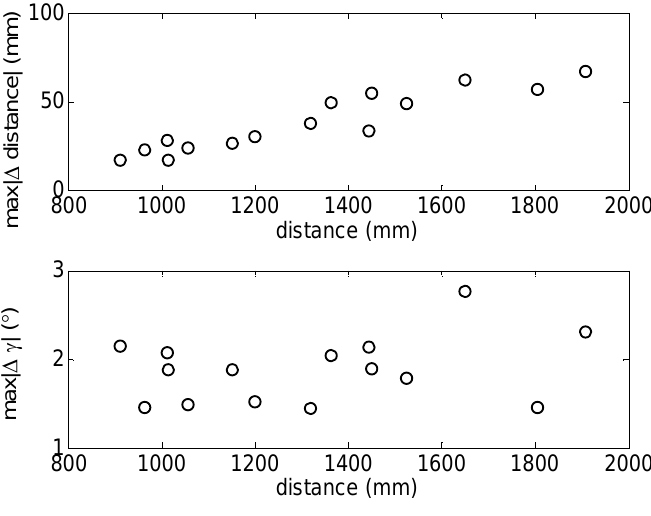
Figure 14. Maximum incremental values of the distance (top) and relative angular orientation (bottom) of the frontal line for different distance ranges.